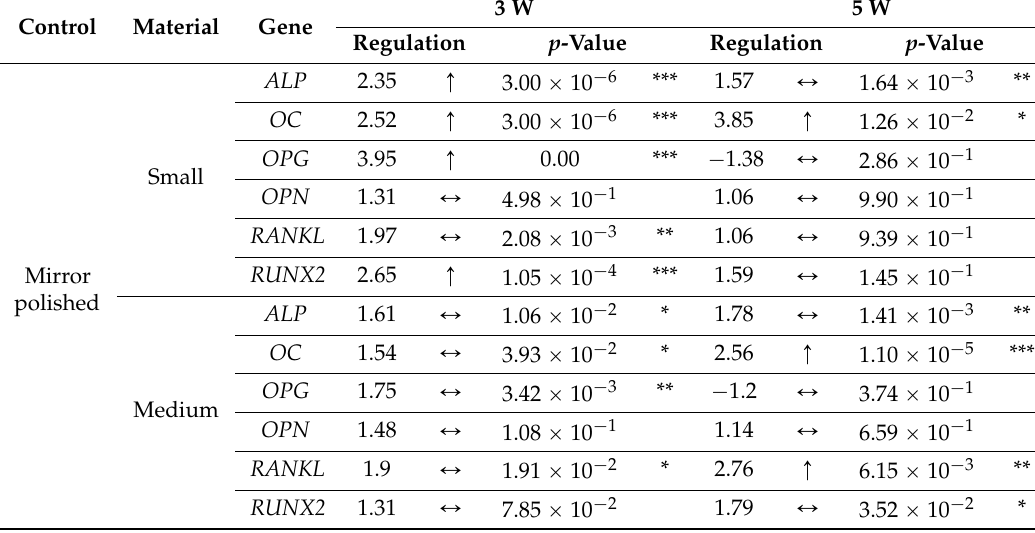
Table 4. The influence of porosity on Saos-2 gene expression was determined via real-time PCR analyses by normalizing each material (Small, Medium, Mixed, and Large) to the mirror polished (MP) sample (control) ( ∆∆ C t ) after three weeks (3 W) and five weeks (5 W). Regulation: fold expression values are compared to regulation threshold ( Ò up regulation, Ó down regulation, and Ø no